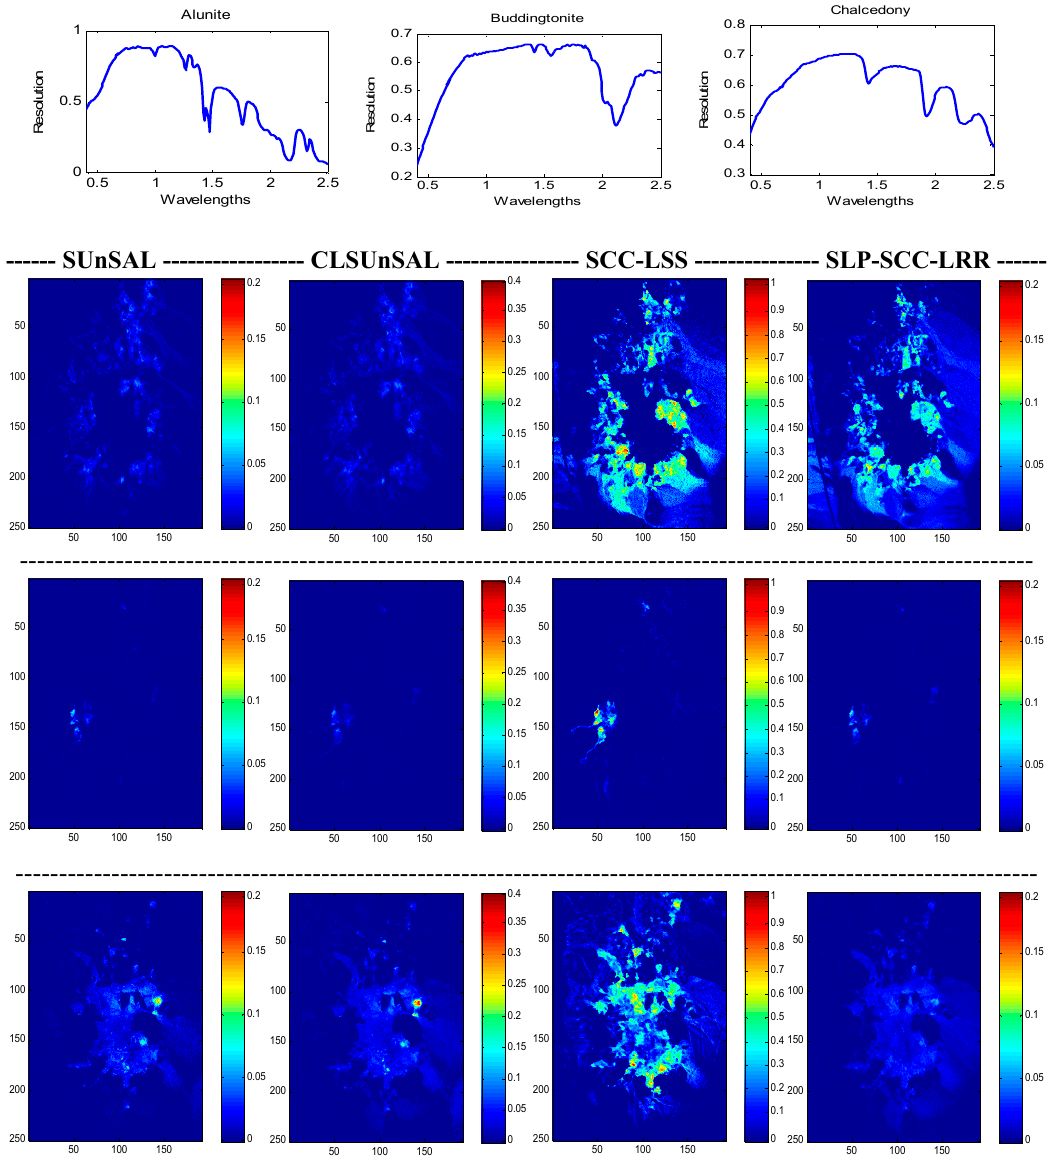
Figure 9. Abundance maps estimated for the minerals alunite, buddingtonite, and chalcedony by applying the SUnSAL, CLSUnSAL, SCC-LRR, and SLP-SCC-LRR algorithms to the AVIRIS Cuprite scene using the library A .